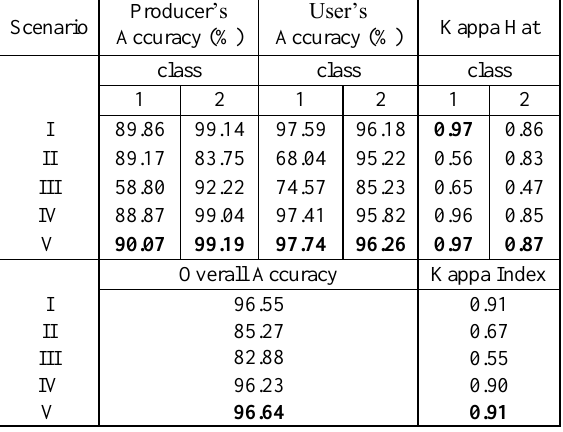
Table 4. Accuracy and Kappa Index for validation